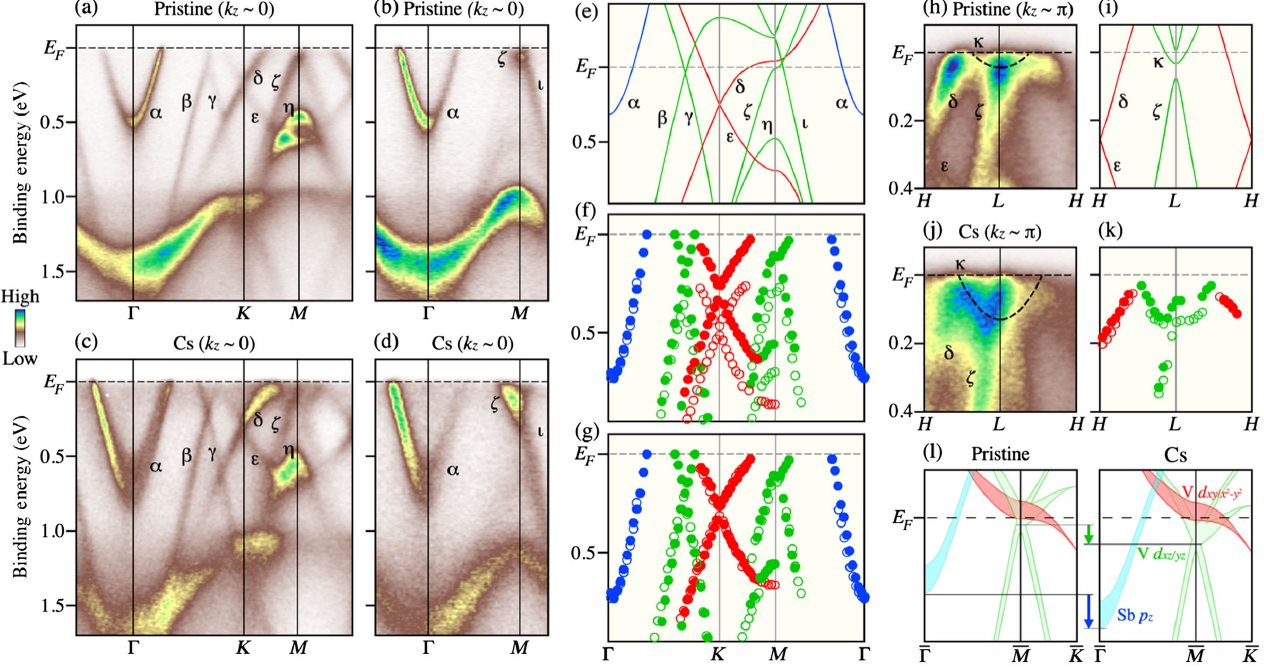
FIG. 2. (a),(b) ARPES intensity as a function of wave vector and binding energy ( E B ) in a wide E B range, measured at T ¼ 120 K along the Γ KM and Γ M lines, respectively, for pristine sample. (c),(d) Same as (a) and (b), respectively, but for Cs sample. (e) The calculated band structure along the Γ KM cut. Dominant orbital character of each band is indicated by coloring (blue, Sb p z ; green, V d xz=yz ; red, V d xy=x 2 − y 2 ). Small hybridization at each band intersection was removed from the calculated bands to highlight orbital character of each band. Calculated E F is shifted downward by 90 meV to obtain a better matching with the experimental data. (f) Comparison of experimental band dispersions between pristine and Cs samples (open and filled circles, respectively) extracted from the peak position in the ARPES spectra of (a) – (d). The band dispersion for pristine sample is shifted downward as a whole by 240 meV. (g) Same as (f) but the band dispersion of pristine sample incorporates the band-dependent energy shift: 240 meV for the Sb p z band (blue), 100 meV for the V d xz=yz band (green), and 40 meV for the V d xy=x 2 − y 2 band (red). (h) ARPES intensity at T ¼ 120 K for pristine sample measured along the HL line with h ν ¼ 120 eV. (i) Calculated band structure in the normal state along the HL cut. Calculated E F is shifted downward by 90 meV to obtain a better matching with the experimental data. (j) Same as (h) but after Cs dosing. (k) Same as (g) but for the HL cut. (j) Schematics of band-dependent energy shifts with Cs dosing. k z dispersion of the bulk bands is shown by shaded